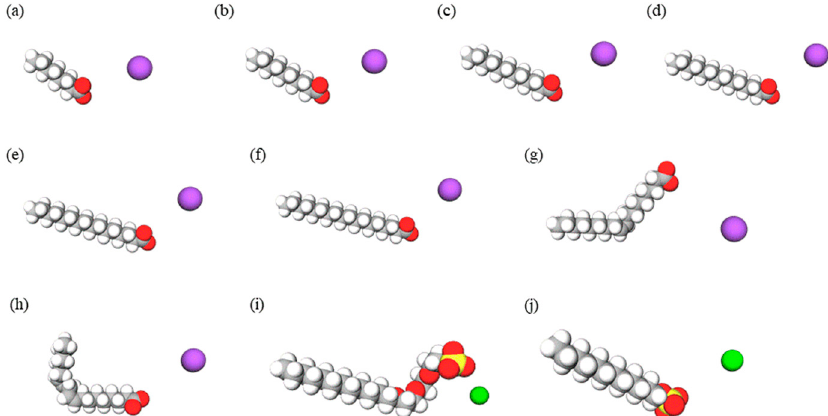
Figure 1. Structures of the fatty acid potassium molecules and synthetic surfactant detergents. ( a ) Potassium caprylate (C8K); ( b ) potassium caprate (C10K); ( c ) potassium laurate (C12K); ( d ) potassium myristate (C14K); ( e ) potassium palmitate (C16K); ( f ) potassium stearate (C18K); ( g ) potassium oleate (C18:1K); ( h ) potassium linoleate (C18:2K); ( i ) SLES; and ( j ) SLS. Carbon: gray, hydrogen: white, oxygen: red, sulfur: yellow, potassium ions: purple, sodium ions: green